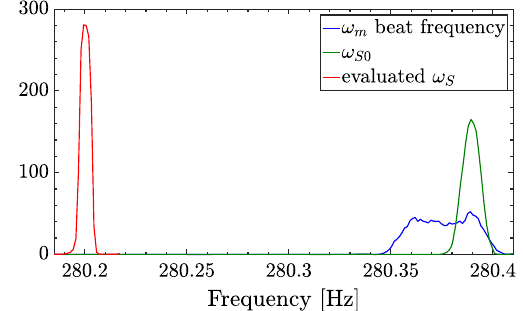
Fig. 8 Distribution of the beat frequency ω m / 2 π , of the first stage of the reconstruction ω s 0 / 2 π and of the final ω s / 2 π